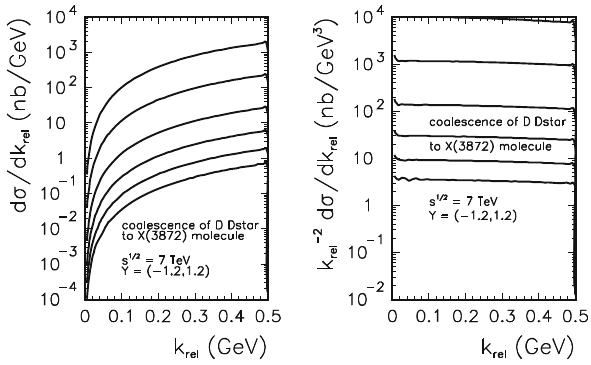
Fig. 6 Distribution in k rel for different windows of p T , c ¯ c = p T , X (left panel) for the CMS kinematics as specified in the main text. In the right panel we show the cross sections divided by k 2 . In these calculations rel the KMR UGDF with the MMHT NLO collinear gluon distribution was used. Branching fractions are included here